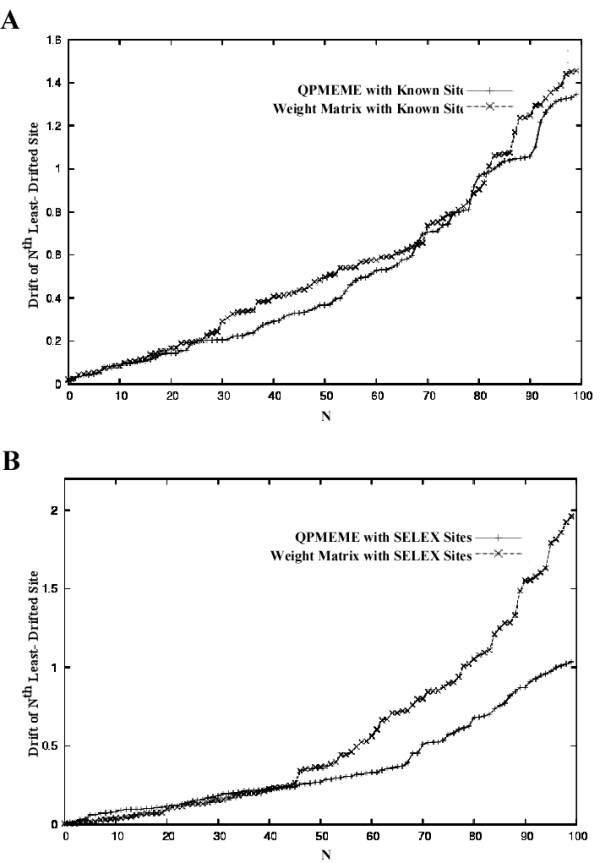
Drift in estimated CAP binding energy between E. coli and S. typhimurium sorted in ascending order plotted against the rank. (A) Using energies estimated by weight matrix or QPMEME based on know sites. (B) Using energies estimated by weight matrix or QPMEME based on the SELEX sites. Note that, for QPMEME estimates based on SELEX data, the energy drift stays low for many sites, as would be expected of most functional CAP targets.